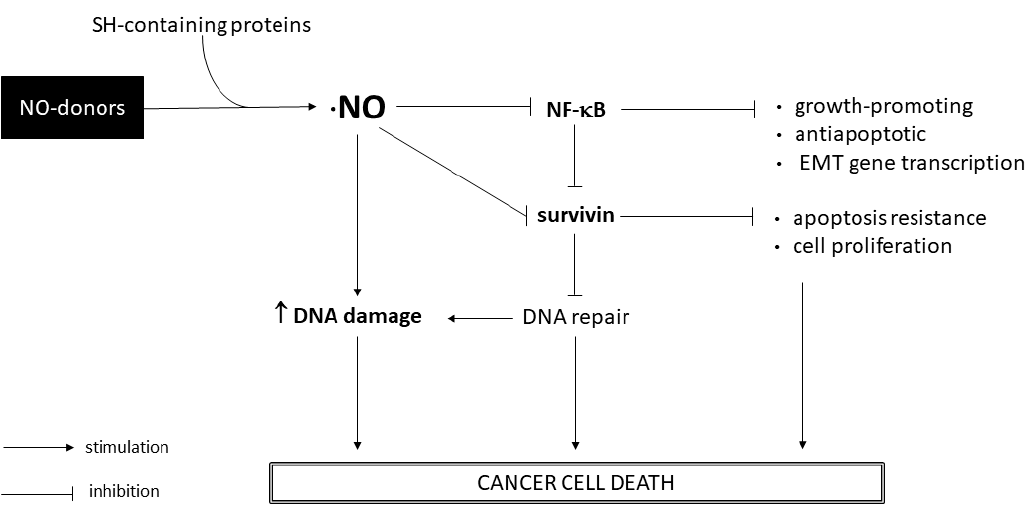
Figure 11. Schematic overview of the main pathways involved in the mode of action of · NO-releasing compounds 1 and 3 .